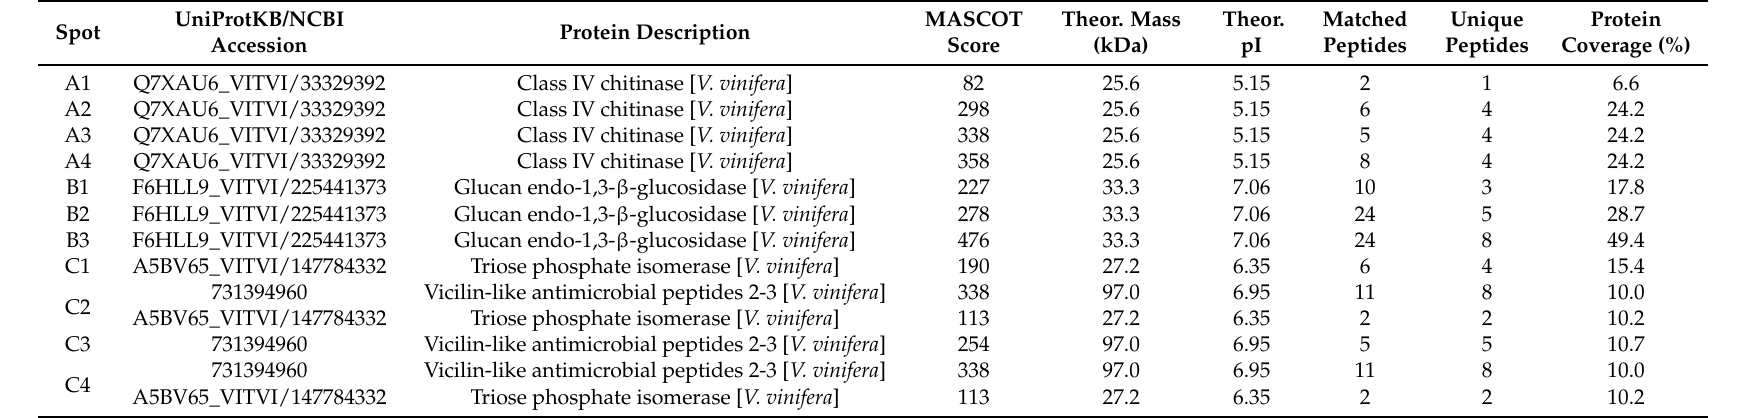
Triose phosphate isomerase [ V. vinifera